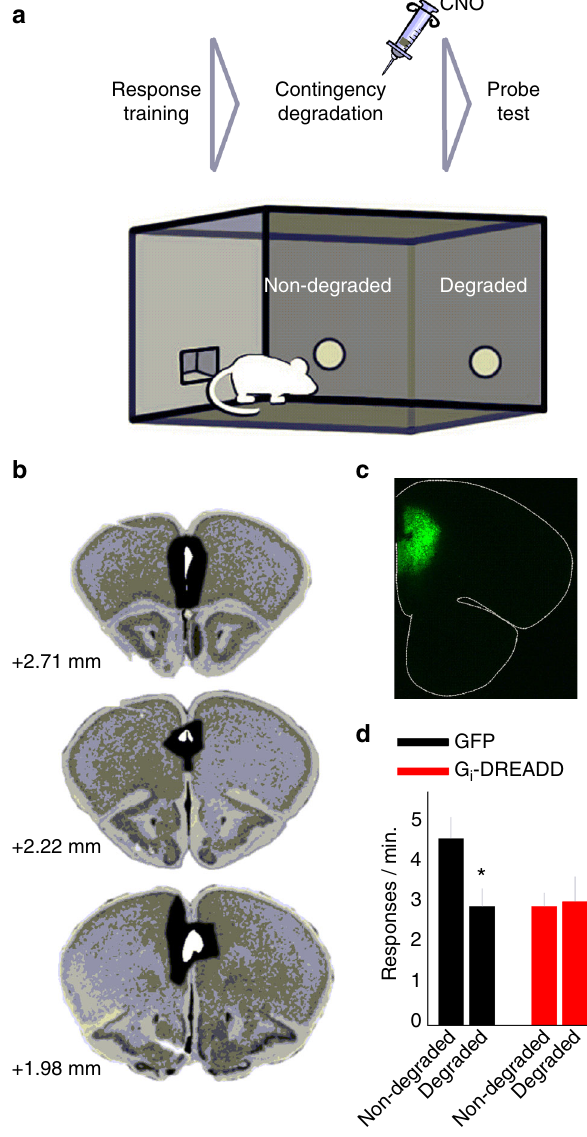
Fig. 1 Prelimbic prefrontal cortex inactivation impairs the ability of mice to select actions based on their consequences. a Experimental timeline: Food- restricted mice are placed in operant-conditioning chambers and trained to respond on two apertures for food pellets. Following training, responding on one aperture continues to be reinforced ( “ non-degraded ” ), whereas food